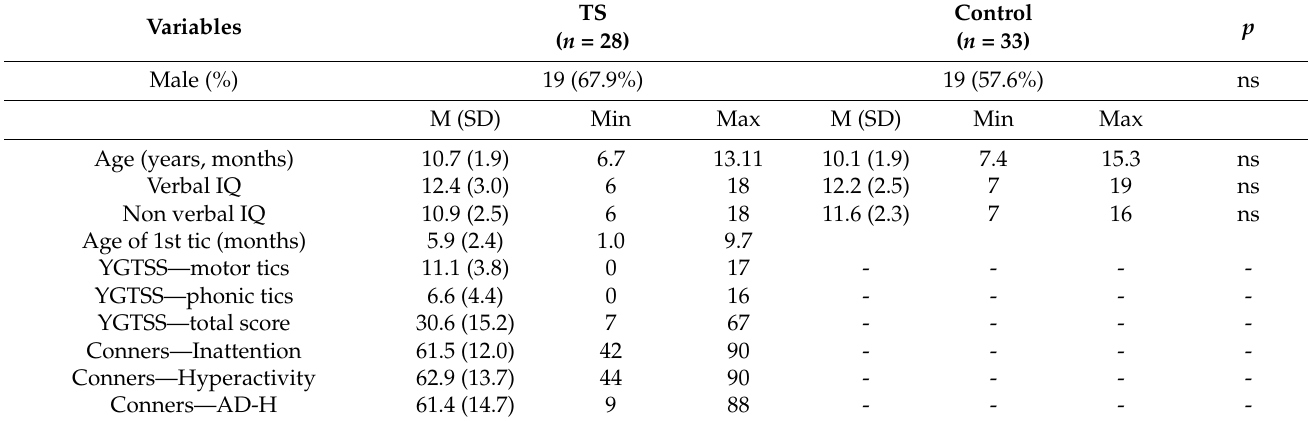
Table 1. Descriptive and Clinical